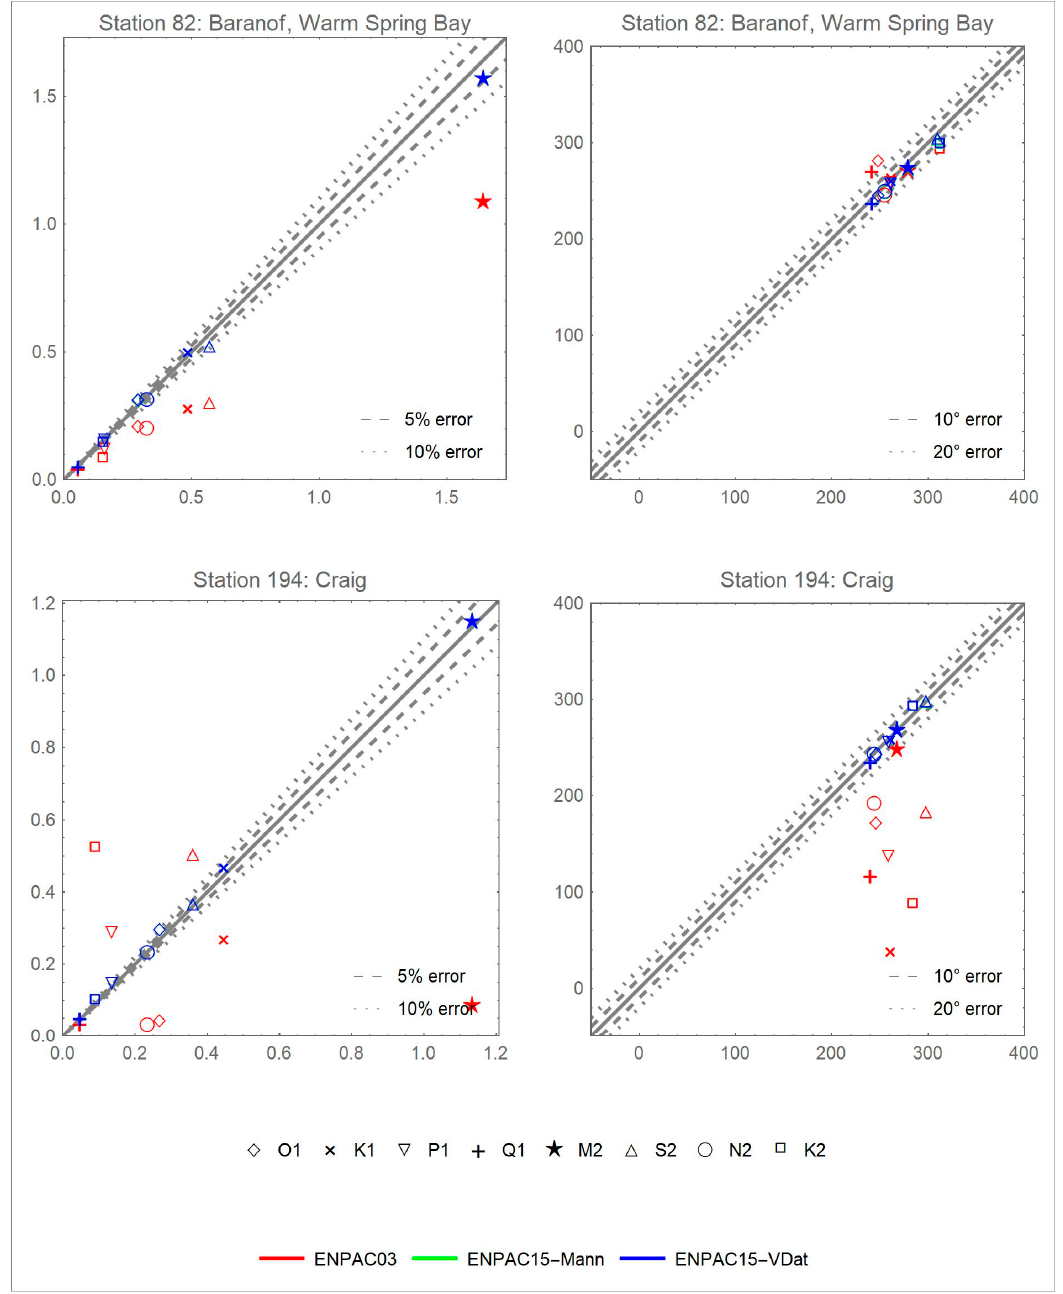
Figure A12. Scatterplots of errors for two Southeast Alaska stations, locations shown in Figure A4.